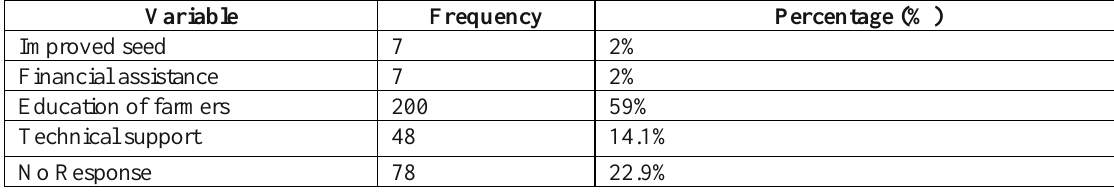
Table 3: Perception of Respondents on the Mode of Operation Adopted for